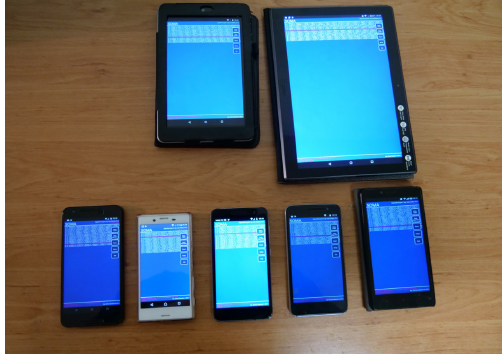
Fig. 6: Used devices, from the bottom, left - Google Nexus 7, Lenovo Tab 4, Google Nexus 5x, Sony